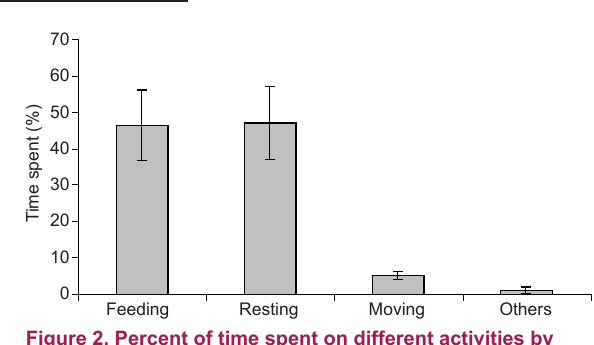
Figure 2. Percent of time spent on different activities by Indian Giant Squirrel in Mudumalai Wildlife Sanctuary (error bar = standard deviation, in activities others include inter- and intra-specific behaviours, drinking, urination, defecation and nest